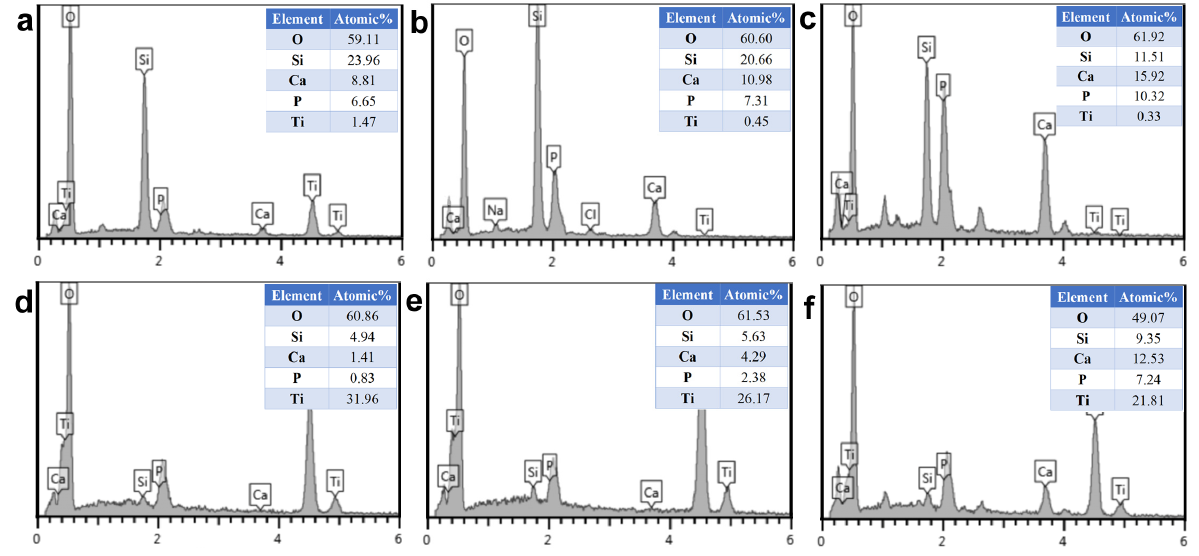
Figure 6. EDS analysis of MBG-SLM-Ti ( a – c ) and MBG-CP-Ti ( d – f ) after immersion in SBF for 1 ( a , d ), 3 ( b , e ) and 7 ( c , f ) days.